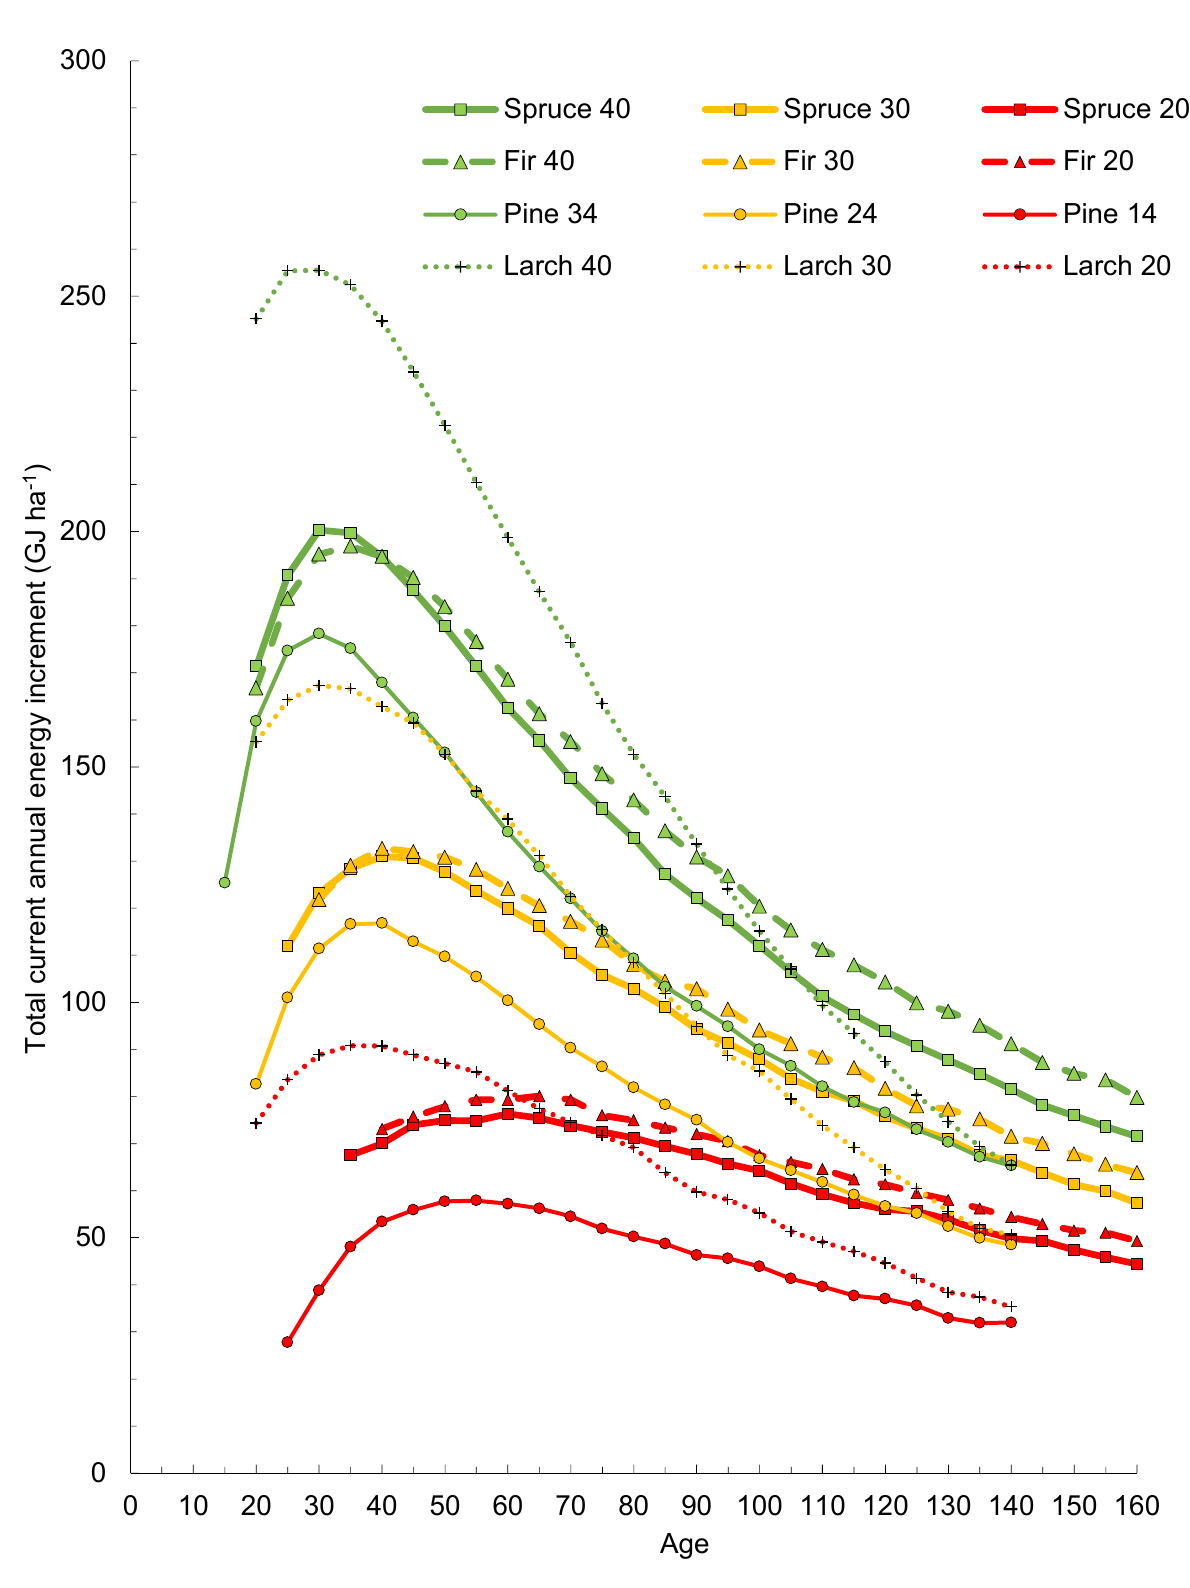
Figure 4. Development of energy reserves in the total current annual increments of coniferous stands depending on their age and site index (20, 30, 40 for spruce, fir and larch; 14, 24, 34 for pine).